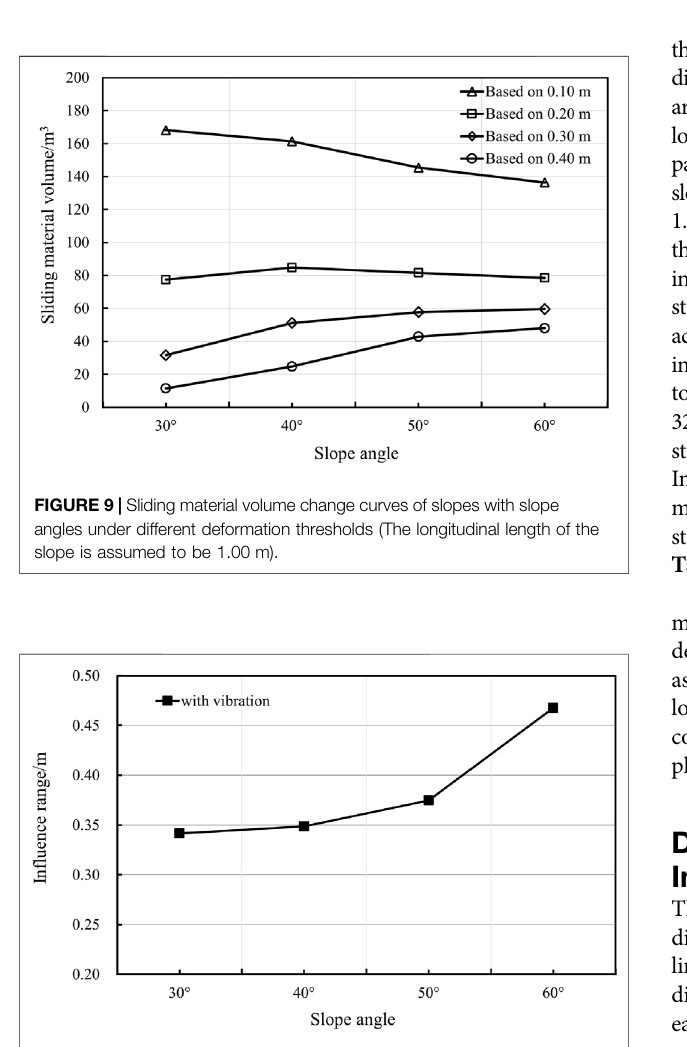
FIGURE 10 | Change curves of the in fl uence range of slopes with slope angles.